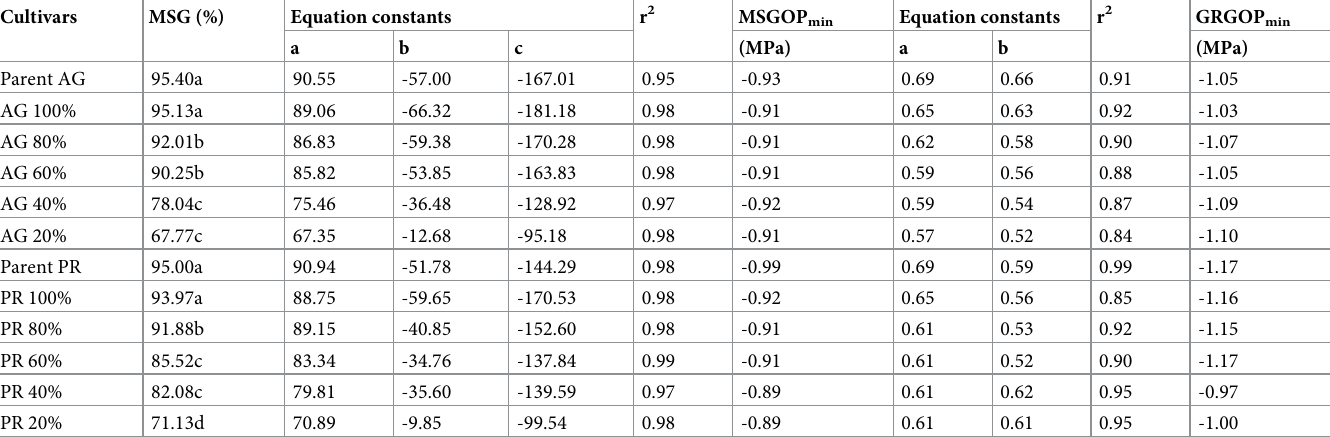
Table 2. Maximum germination and estimated parameters of soybean seed from the F1 generation as a function of osmotic potential.